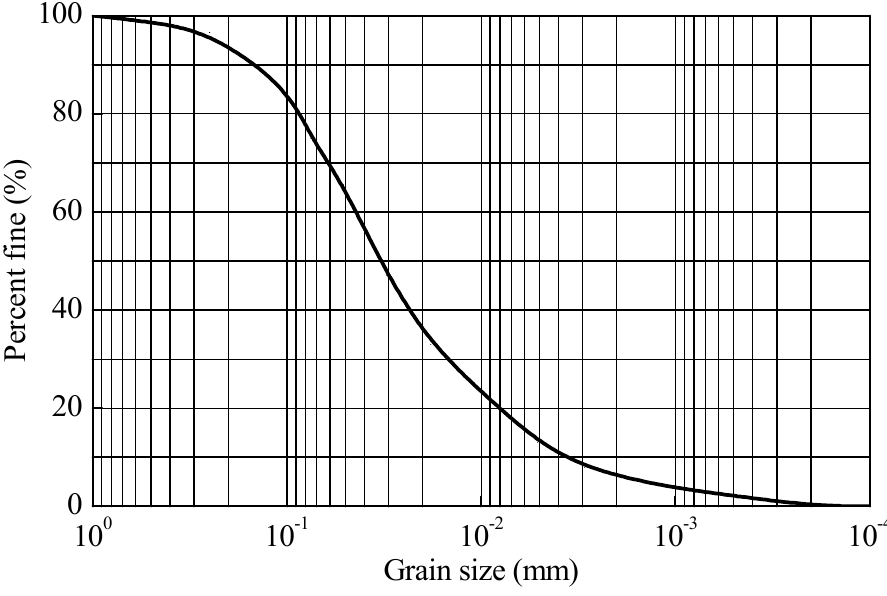
Figure 3. Grain size distribution of silty clay.